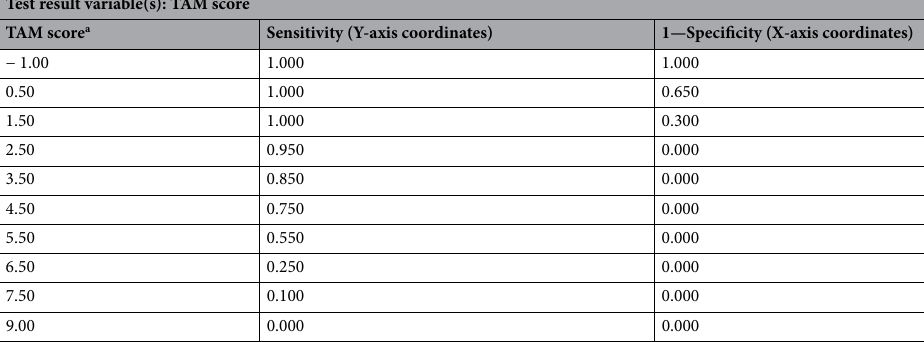
Table 6. Sensitivity and 1-specificity values at different AMS, calculated on the basis of the ROC curve (Coordinates of the curve) in S–S kinship analysis by autosomal STR. The smallest cutoff value is the minimum observed test value minus 1, and the most considerable cutoff value is the maximum observed test value plus 1. All the other cutoff values are the averages of two consecutive ordered observed test values.